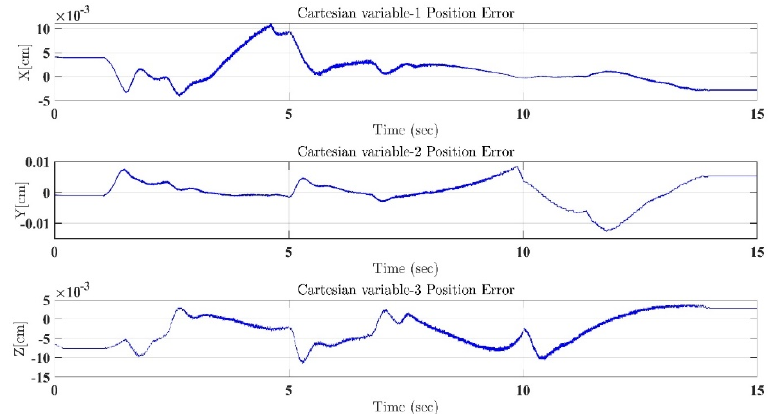
Figure 10. Tracking errors in Cartesian coordinates (X-Y-Z axes) under the conventional super- twisting controller.